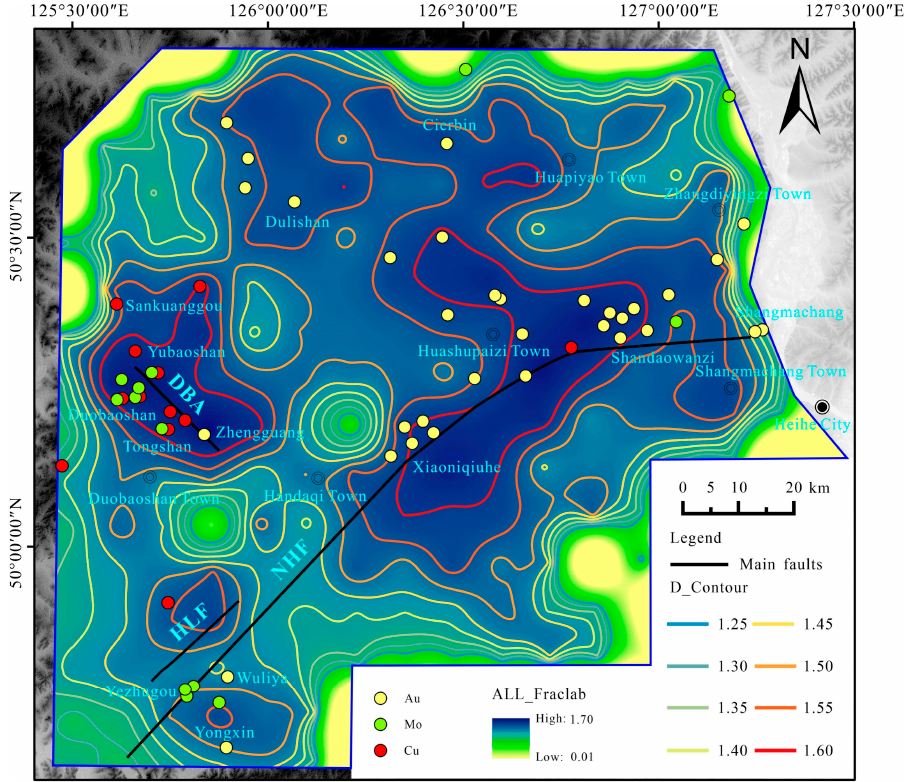
Figure 7. Contour map of the fractal dimension of the lineaments in the study area.